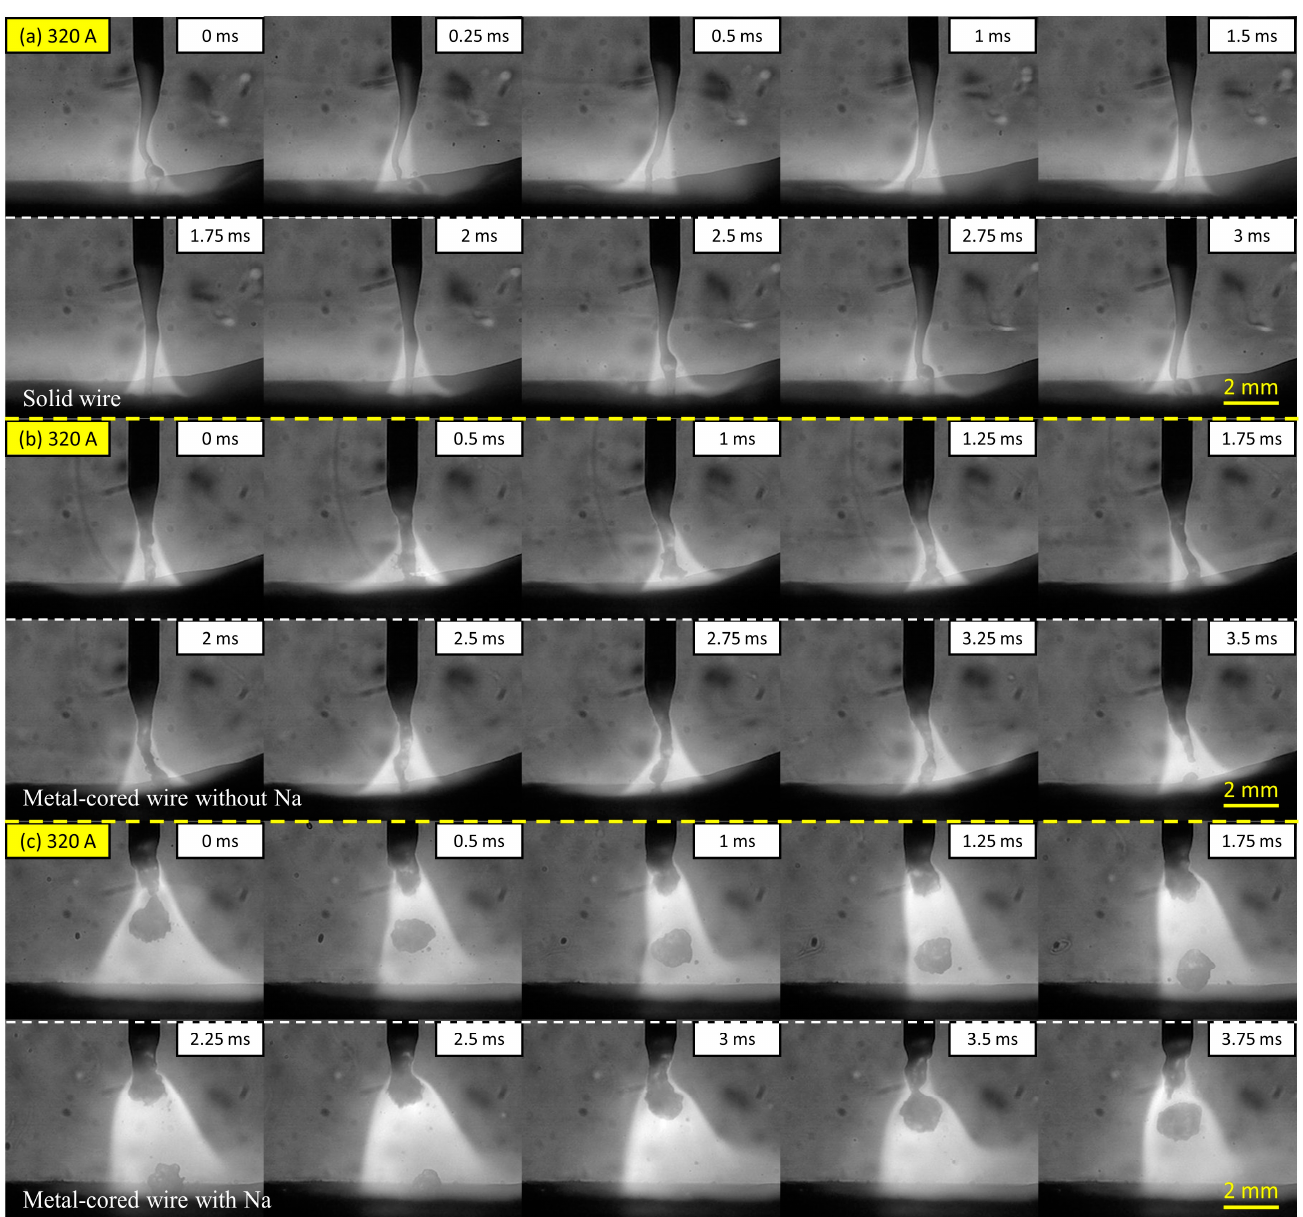
Figure 3. Metal transfer in wire 1 ( a ), wire 2 ( b ), and wire 3 ( c ) at 320 A welding current.